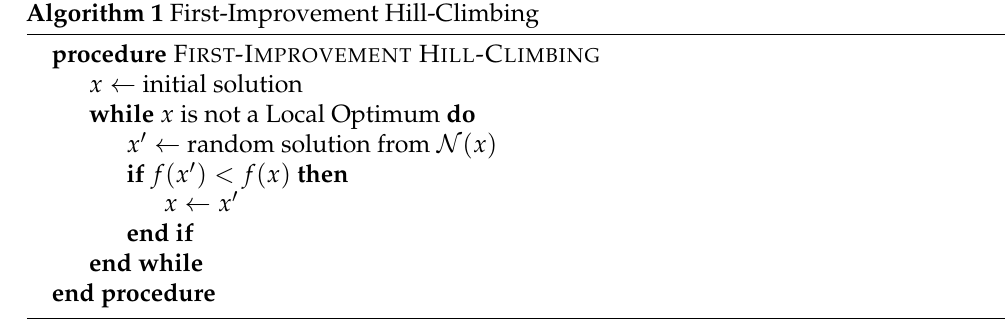
Algorithm 1 First-Improvement Hill-Climbing procedure F IRST -I MPROVEMENT H ILL -C